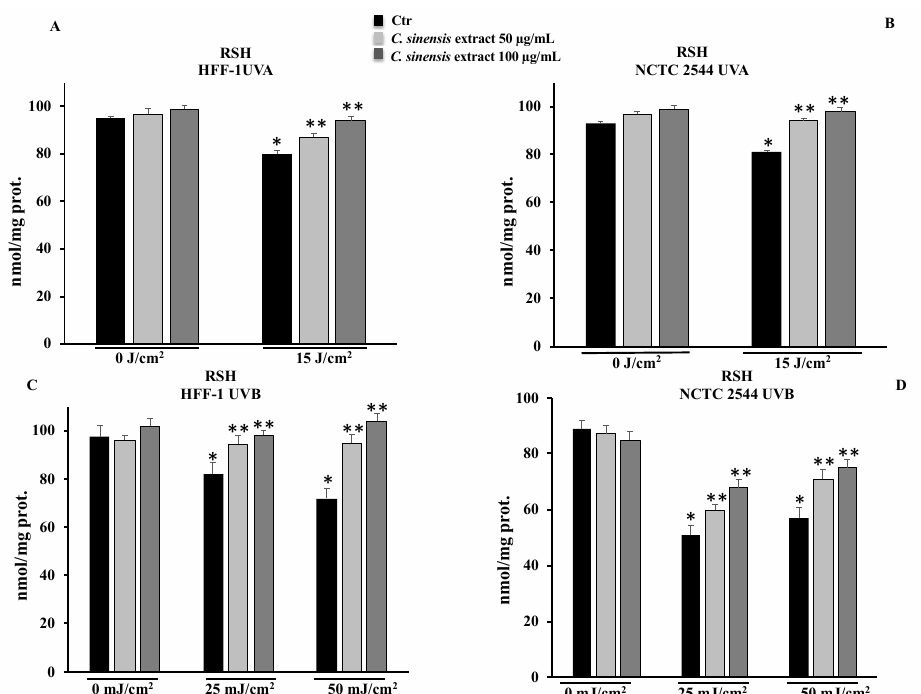
Figure 5. Total thiol groups in HFF-1 ( A , C ) and NCTC 2544 ( B , D ) cells untreated (Ctr) and treated for 4 h with C. sinensis extract at different concentrations (50–100 µg/mL) and irradiated with 15 J/cm 2 of UVA and/or with 25 mJ/cm 2 or 50 mJ/cm 2 of UVB. Values are the mean ± S.D. of four experiments in triplicate. * Significant vs. untreated control cells: p < 0.001; ** Significant vs. untreated irradiated cells: p < 0.001.